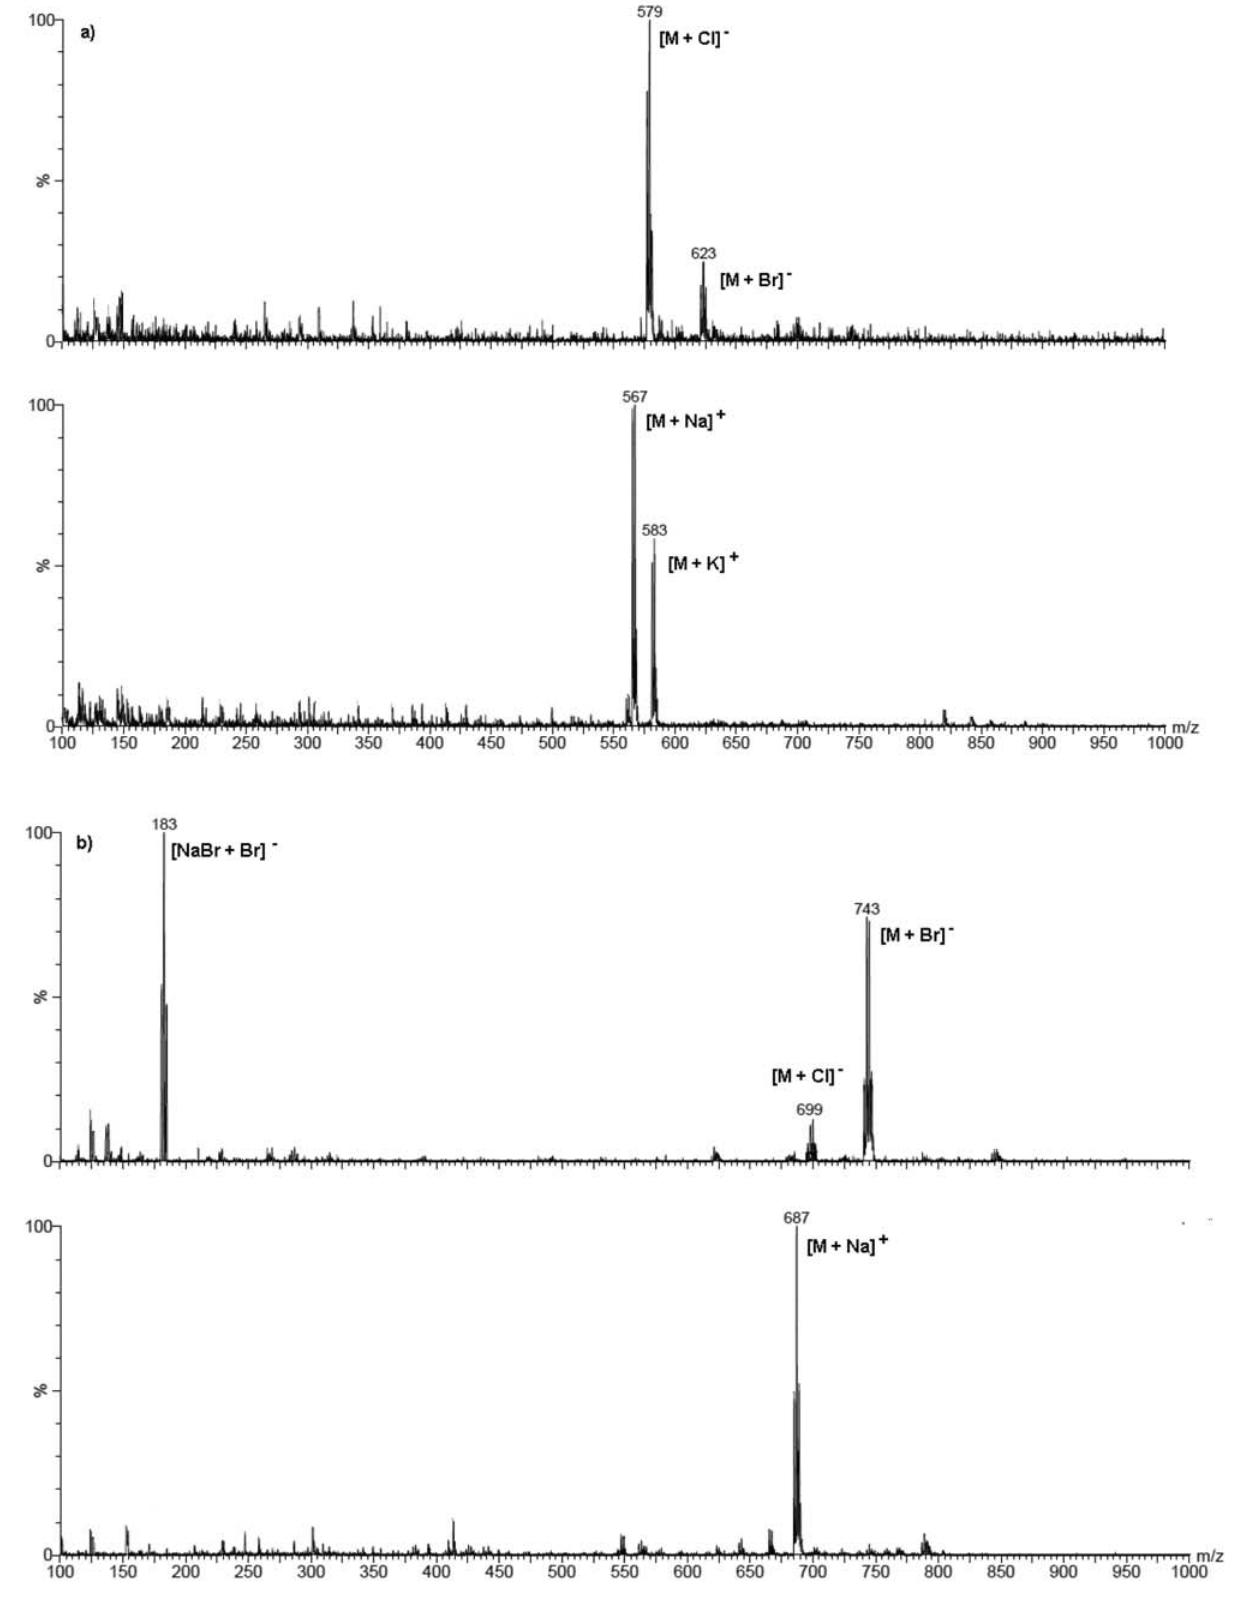
Figure 7. ESI-MS spectra in the negative and positive ion mode of compounds 7 (a) and 9